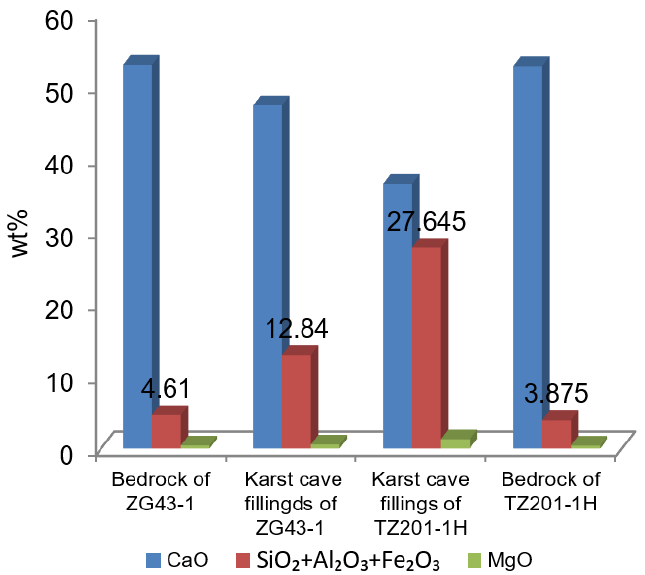
Figure 7. Distribution of chemical composition of fillings in the Yingshan Formation caves.